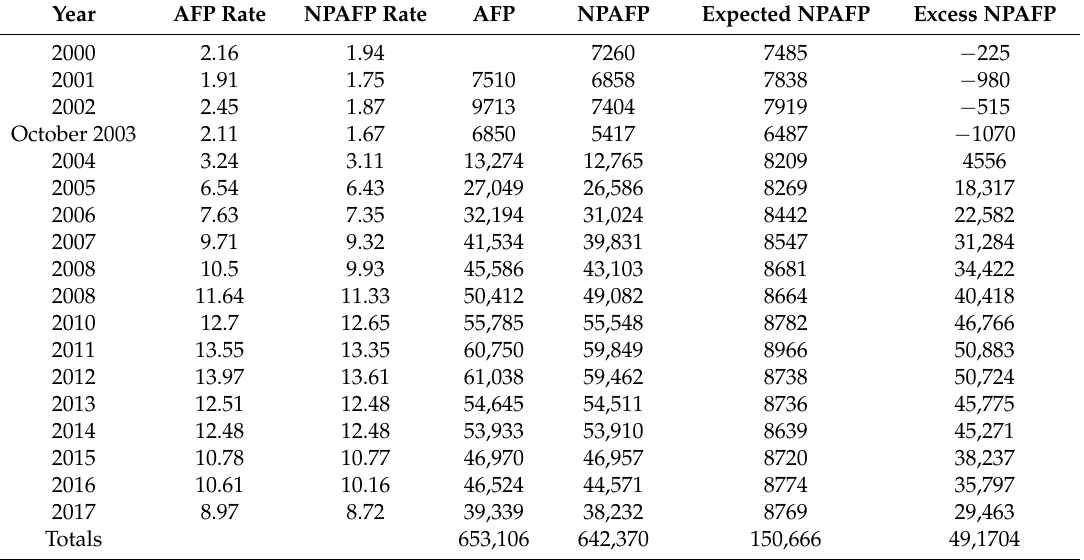
Table 2. Excess NPAFP in each year from 2000–2017.